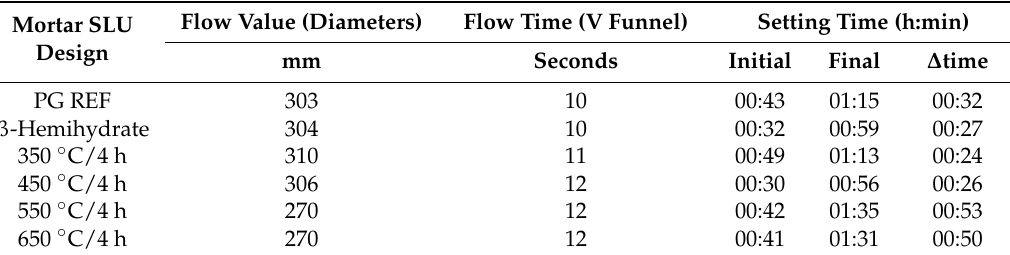
Table 8. Workability and setting time of